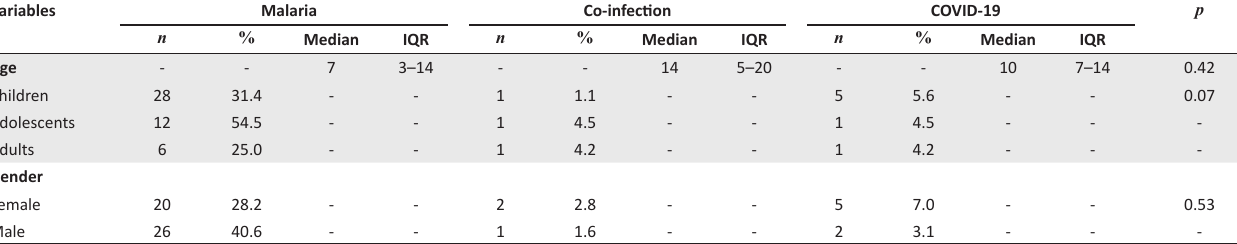
TABLE 2: Single and co-infection frequency according to age and gender. Variables